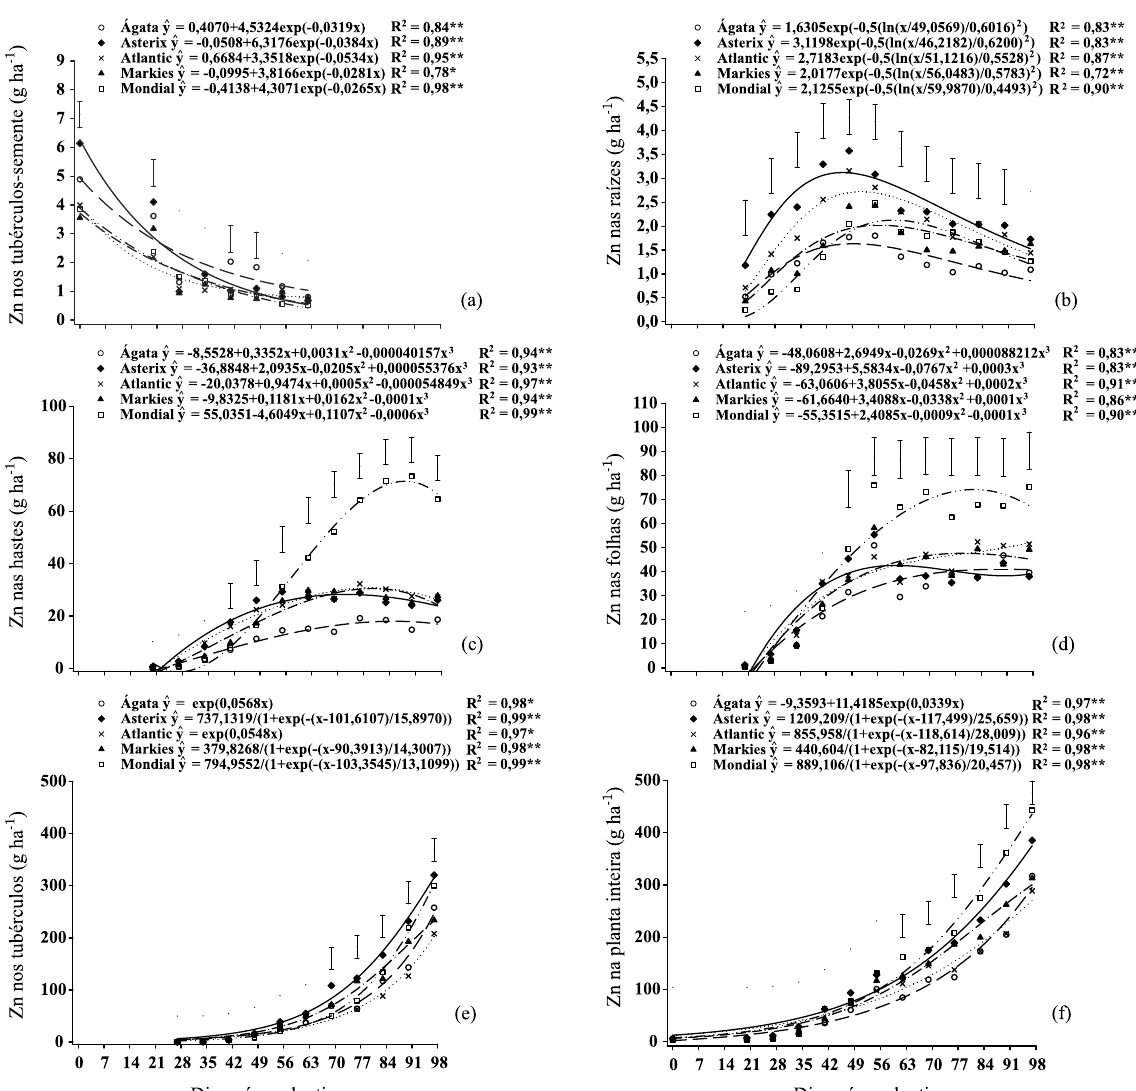
Figura 6. Quantidade de Zn nos tubérculos-semente (a), raízes (b), hastes (c), folhas (d), tubérculos (e) e na planta inteira (f) de cultivares de batata ao longo do ciclo. * e **: significativos a 5 e 1 % pelo teste F. Barras verticais indicam o valor de DMS pelo teste de Tukey a 5